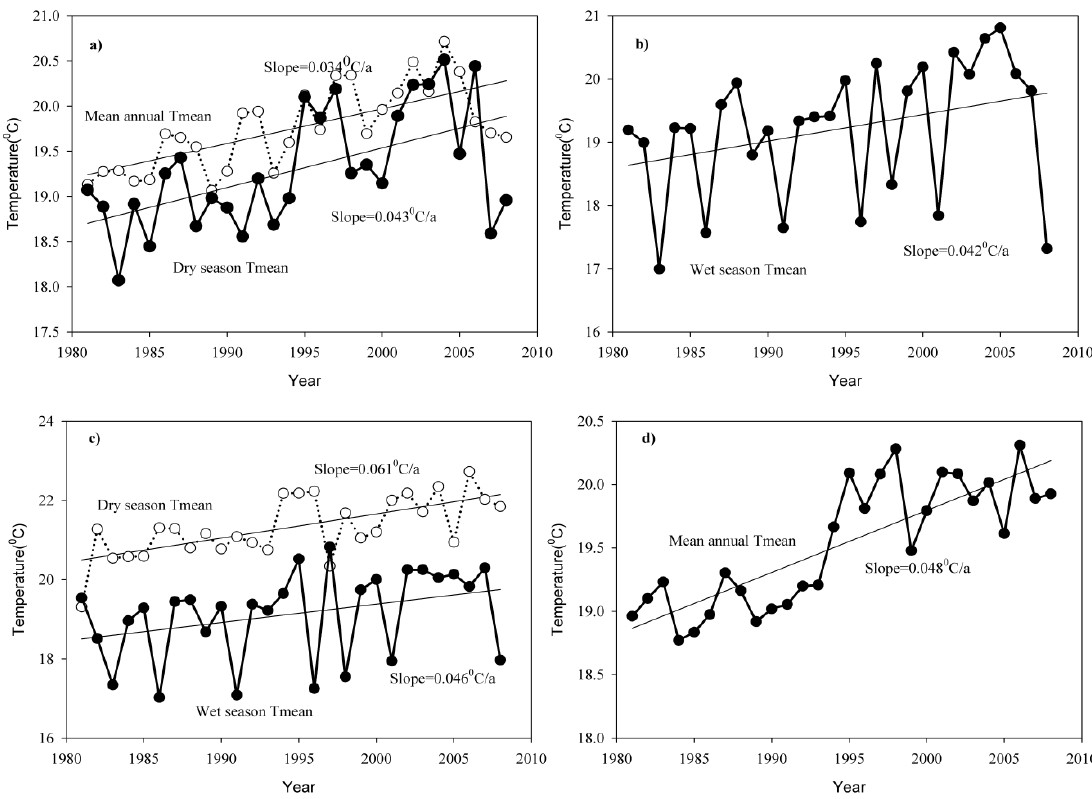
Figure 3. Mean annual and seasonal temperature trends for selected stations in upper Omo-Ghibe basin: ( a ) and ( b ) for Assendabo station, ( c ) and ( d ) for Jimma station.